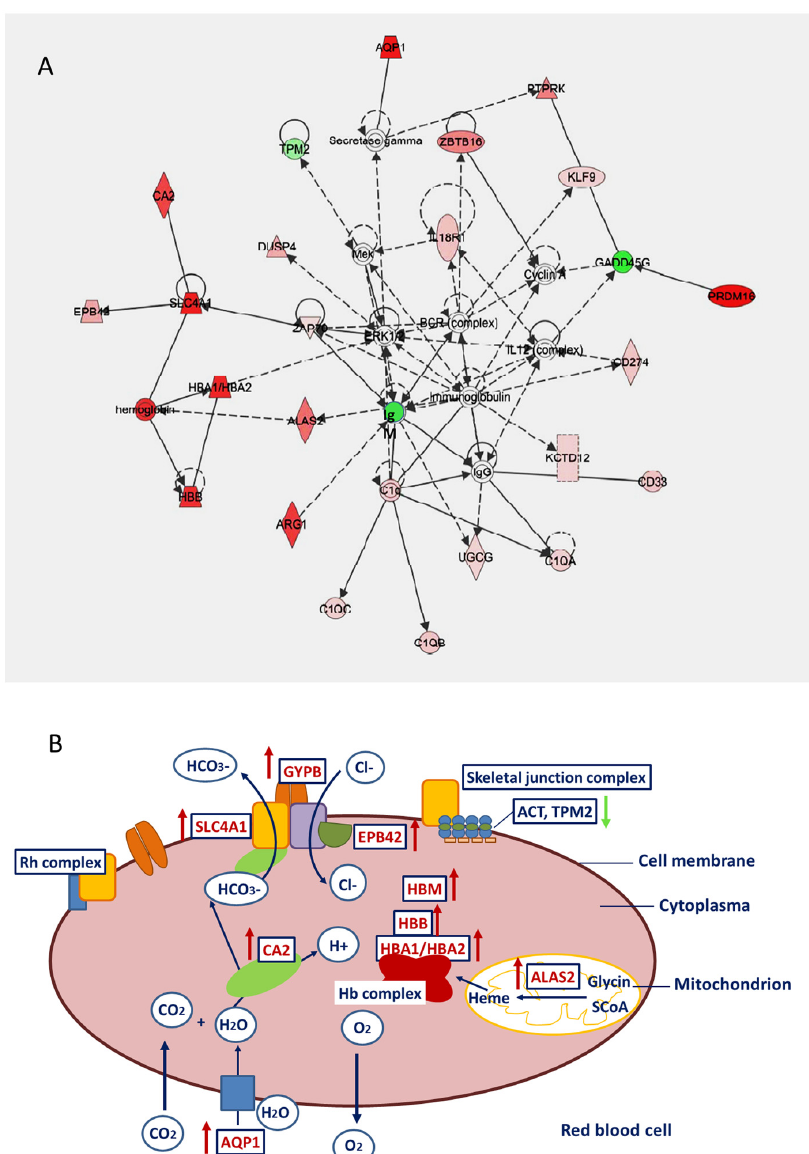
Fig 5. Vaccination-induced upregulation of erythrocyte-specific genes involved in gas exchange in early lactating cows. A: Interaction network for erythrocyte-enriched genes modulated in cows vaccinated after calving (AC) using IPA network analysis. Red: upregulated loci, green: downregulated loci. B: Model of the synergistic coactions of genes from the integrated gas exchange in the red blood cell. Genes (blue- framed boxes) upregulated in response to vaccination are indicated by red arrows. AQP1: aquaphorin, SLC4A1: band 3 anion exchange protein, CA2: carbonic anhydrase II, GYPB: glycophorin B, HBA, HBB: hemoglobin chains A and B, HBM: μ -globin, ALAS2: 5-aminolevulinate synthase 2, EPB42: erythrocyte membrane protein 4.2, ATPIF1: ATPase inhibitory factor 1, ACT: actin, TPM2: tropomyosin